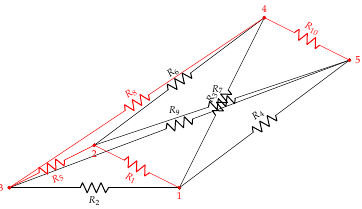
Figure 19. Path for delivering merchandise on the Veracruz-Boca del Rio